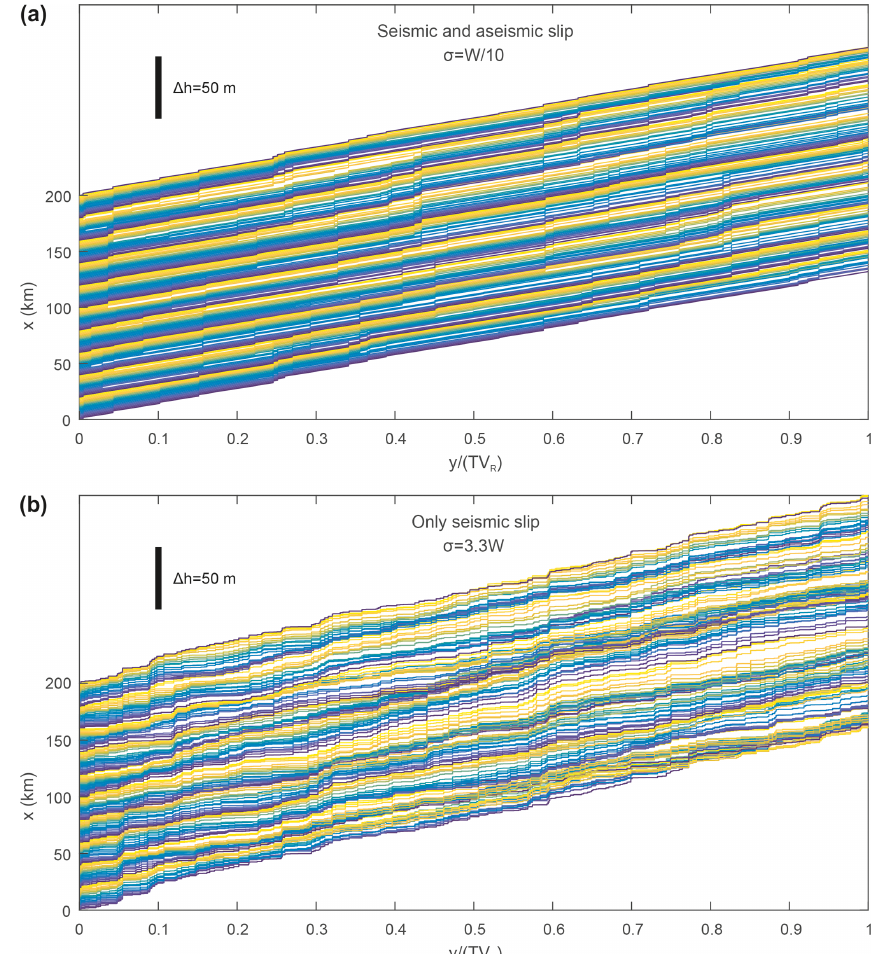
Figure 10. Topography of a set of parallel rivers flowing in an across-strike manner along the fault. (a–b) River profiles of 200 rivers separated by 1km along the strike of the fault, i.e. the x direction. River elevation h is given along the same axis, with a scaling factor of 1000. River length y across the strike of the fault is normalized by knickpoint migration rate V R times the duration of the simulation T . Non-normalized river profiles are shown in Fig. B1. The colour scale is only present to help figure